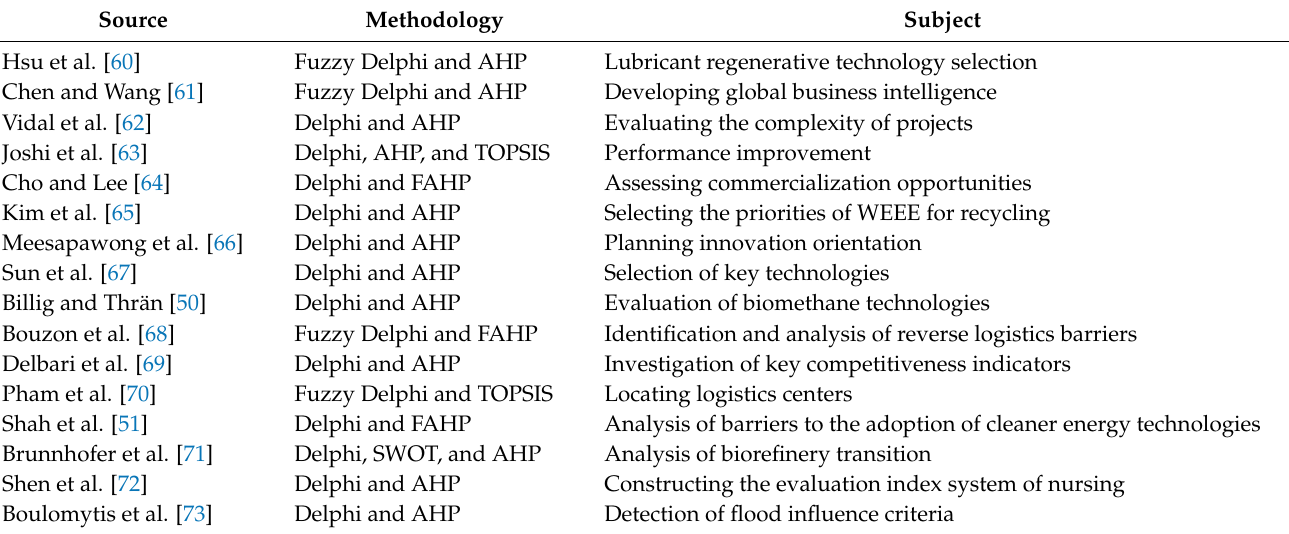
Table 1. Literatures integrating Delphi and MCDM